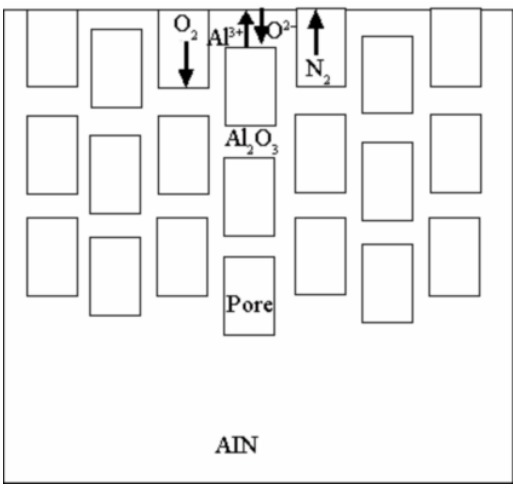
Fig. 5 Schematic showing the formation of the oxide layer during the oxidation of AlN. The oxidation process is mainly the reaction involving the exchange of N 2 and O 2